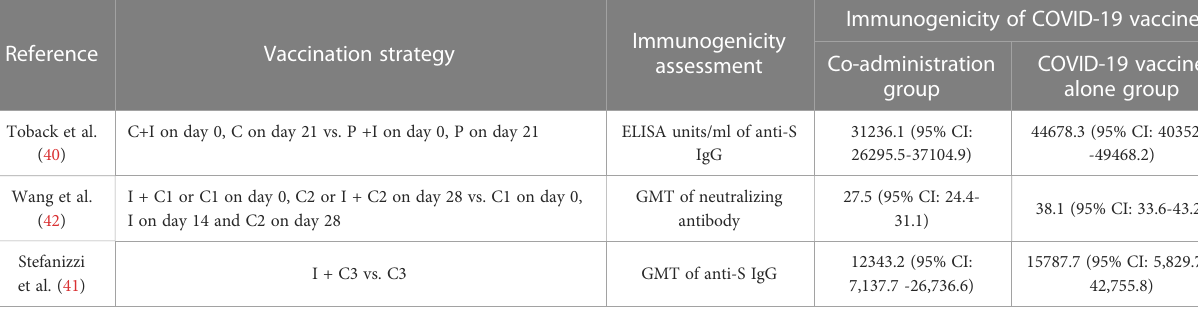
TABLE 3 Immune interference in the co-administration of COVID-19 and in fl uenza vaccines.